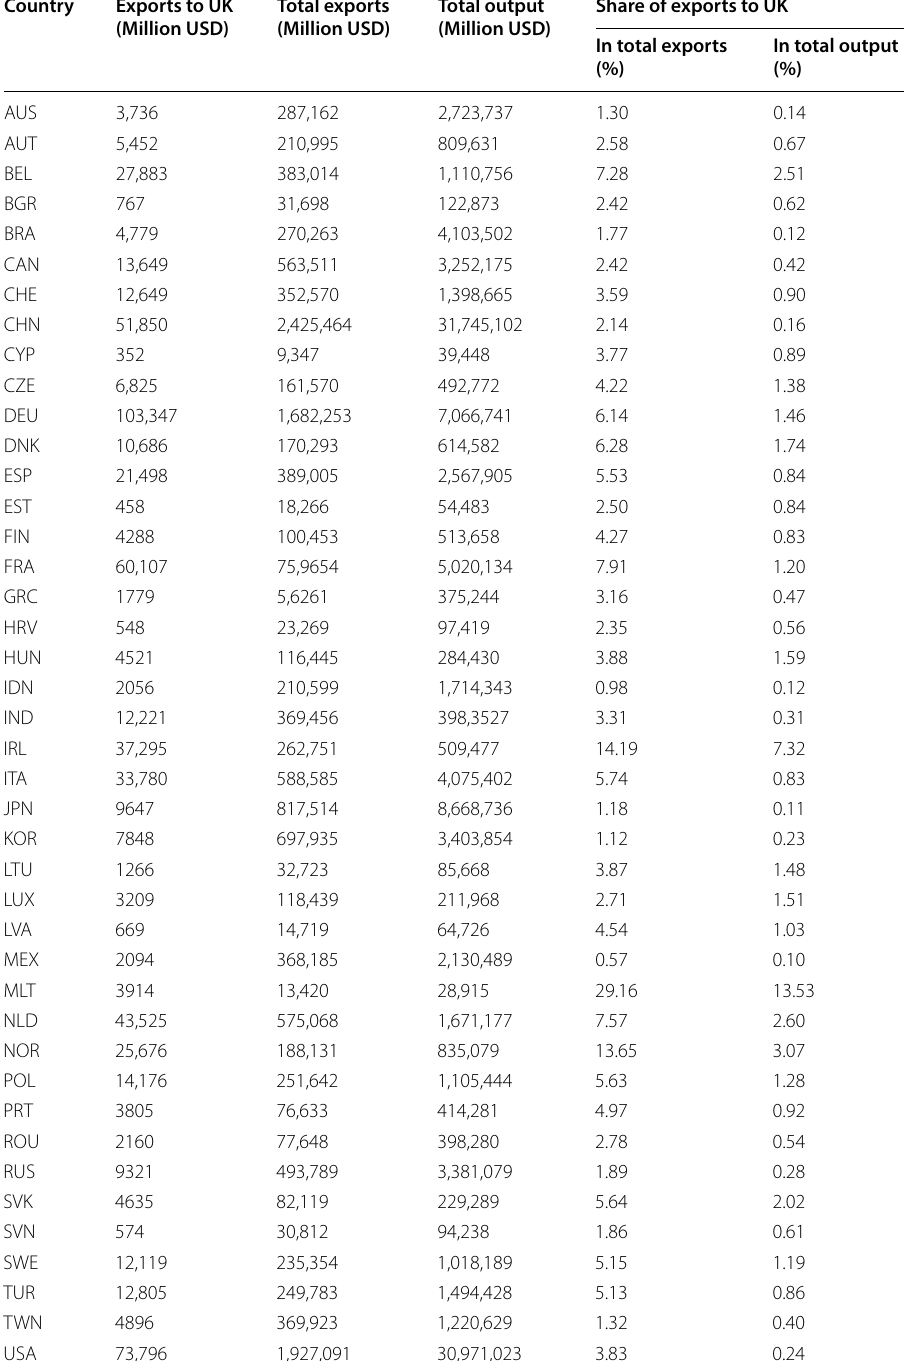
Table 7 Exports to the UK by